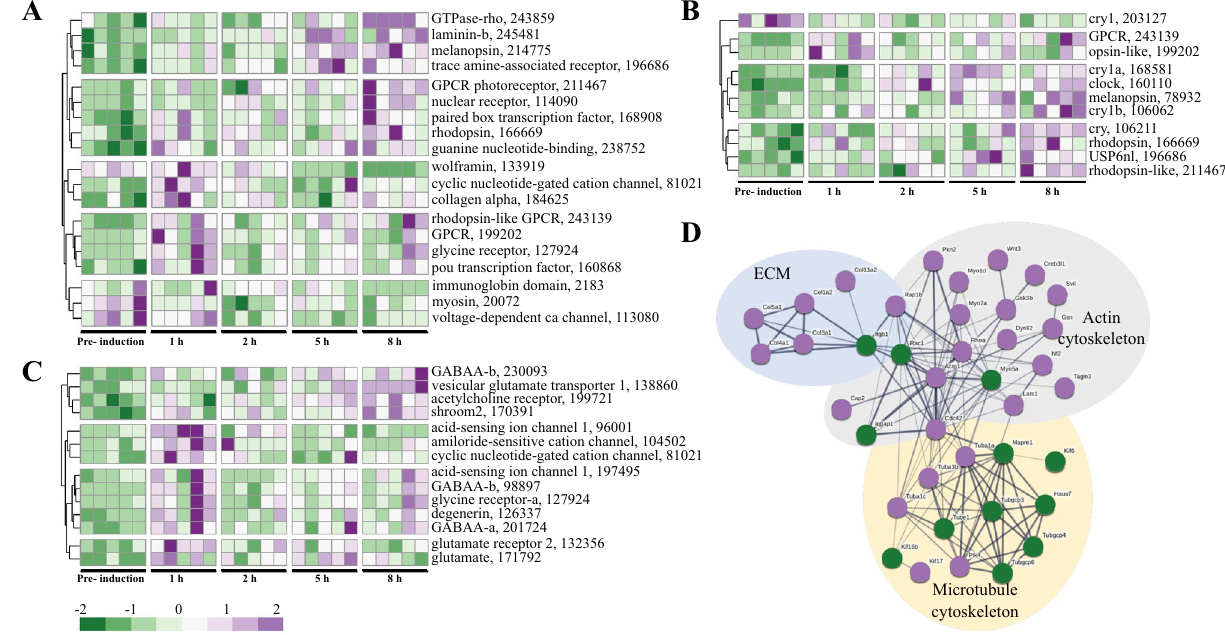
Figure 3. Analysis of transcripts related to light, ion channel, ECM, and cytoskeleton. Heatmap of transcript expression related to ( A ) sensory perception of light stimulus (GO:0050953), ( B ) photoreceptor activity (GO:0009881) and photoperiodism (GO:0009648) and ( C ) ligand-gated ion channel activity (GO:0015276) at the different sampling time points during induction, relative to the pre-induction control (FDR < 0.05). Rows represent transcripts, columns represent the tested individuals (n = 5 per time point). Expression level is indicated by z-score. Numbers are JGI IDs. ( D ) STRING visualization of protein interactions of cytoskeleton- and ECM-related transcripts. Upregulated transcripts are in purple and downregulated in green. The proteins presented in the network are mouse homologs. Thickness of the connecting lines indicates the strength of data